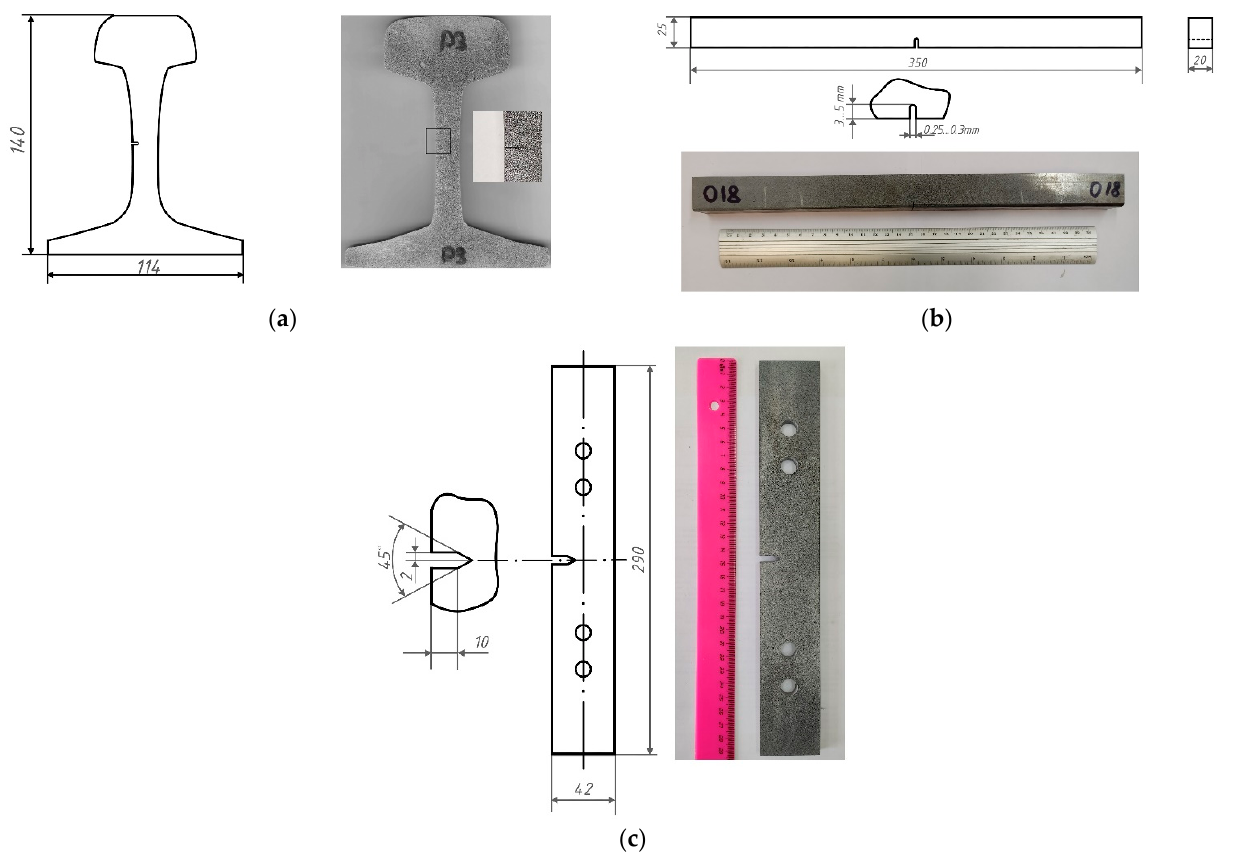
Figure 1. Schemes and photos of the samples made from rail ( a ), wheelset ( b ), and traction clamp ( c ).